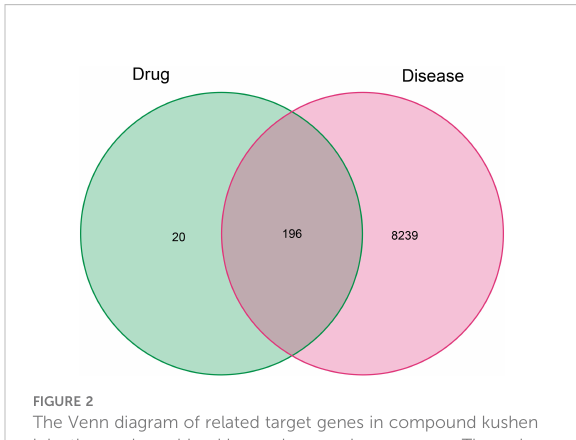
FIGURE 2 The Venn diagram of related target genes in compound kushen injection and combined lung adenocarcinoma genes. The red and green ovals represent the identi fi ed LUAD and drug targets